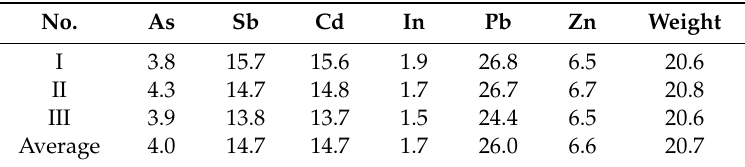
Figure 6. XRD pattern of the leach residue from the APOL process. Table 4. Main chemical composition of the leach residues with corresponding weights under the optimized conditions (wt. %, g).